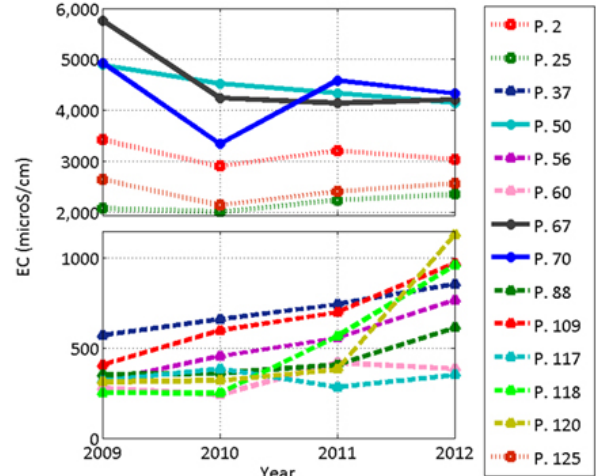
Fig. 3. Averaged EC of selected ponds in the St. Denis NWA from 2009 to 2012. Solid, dot, and dashed lines indicate brackish-saline, moderately brackish, and freshwater wetlands, respectively.